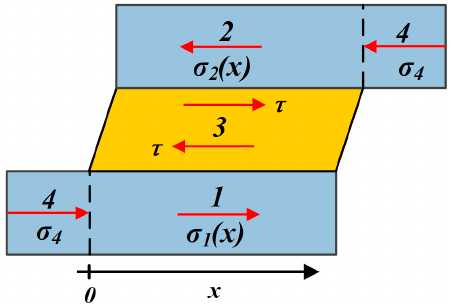
Figure 3. Schematic image of the deformed unit cell at “phase 1”. The geometry and material parameters are inherited from Figure 2. (a) Stress only distributed in Regions 1, 2, 3, 4 because of the breakage of Region 5. Origin “o” and “x-axis” represent the coordinate.